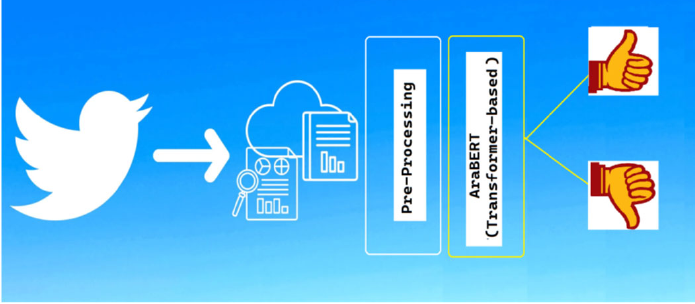
Figure 6. The proposed AraBERT overview.